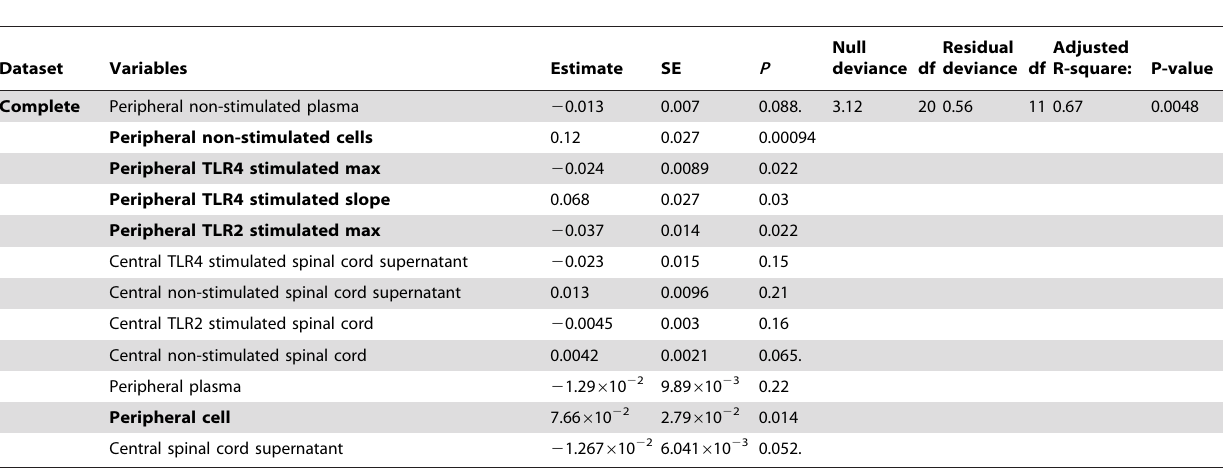
Table 7. Best-fit logistic regression model results for the prediction of the pain severity in rats post CCI in neuronal experimental